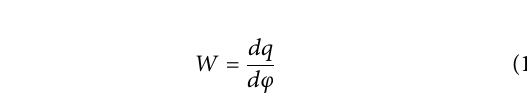
FIGURE 1 | PHL varying with the frequency of the excitation voltage (A) . PHL with excitation voltage amplitude (B) . Voltage and current sequence diagram (C)